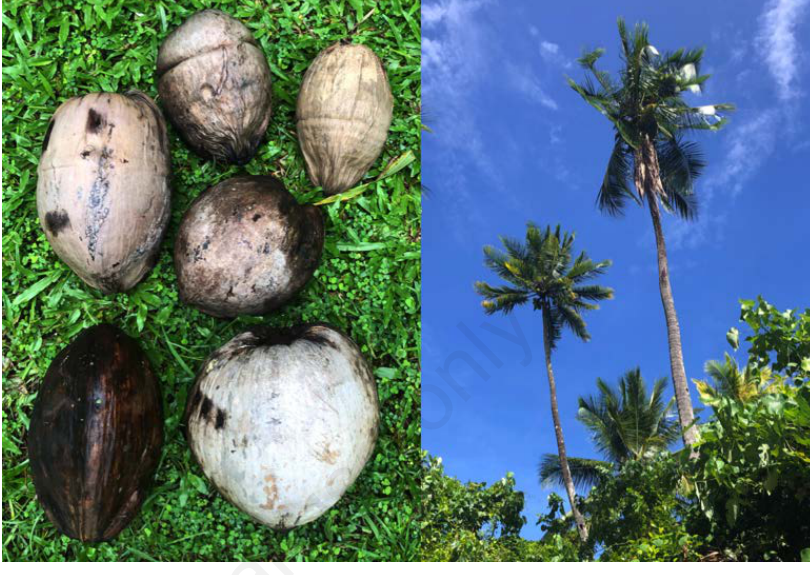
Figure 4. Left Side: Examples of nuts found in the Wonga Beach region. Bottom Left is a niu kafa. Bottom Right is a niu vai. The nuts in the middle are examples of intermediate forms. The nuts at the top of the picture are small nuts that grow on tall trees that may be examples of ancestral wild-type coconuts. Apart from the large round niu vai, these types of nuts were not introduced for copra production and are examples of native Australian phenotypes. Right side: Self-sown palms on the littoral edge, at Rocky Point. The palm in the front center is a wild-type niu kafa, the palm on the left is a niu kafa intermediate-type. The palm with the larger fronds in the middle is a niu vai. The niu vai clearly has larger fronds and a fuller crown than the other palms in the picture, even though it is further back.